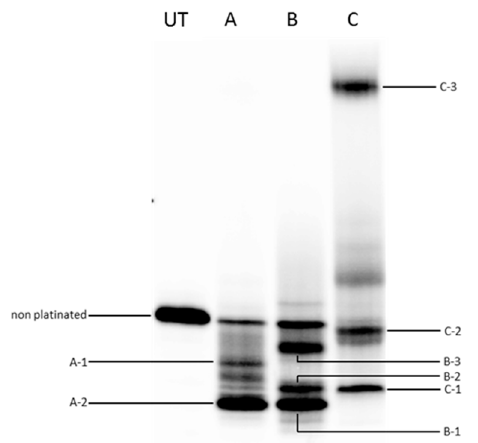
Figure 4. The denaturating gel electrophoresis (15% acrylamide) of platination adducts generated by ( A ) Pt-ttpy , ( B ) Pt-tpy , and ( C ) Pt-BisQ in the presence of c-myc (10 µM for ( A ) and ( B ) and 100 µM for ( C )) in K + 100 buffer after 18 h incubation at 32 °C. UT is untreated.